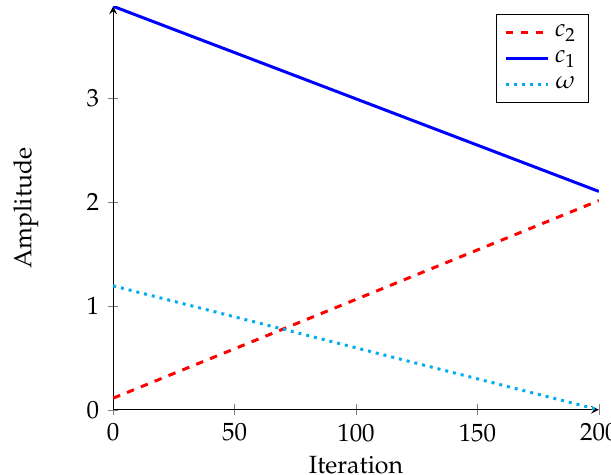
Figure 3. Changes in parameters of modified